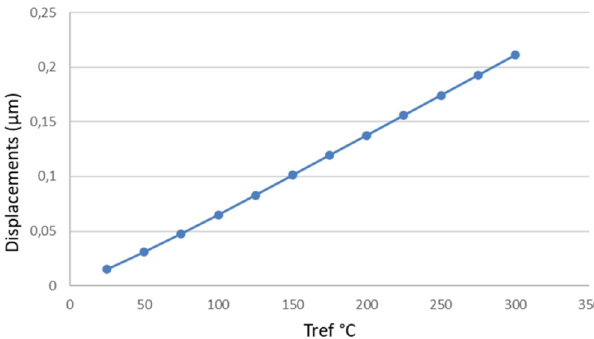
Fig. 6. Evolution of maximum displacements as a function of the reference temperature in the HEMT structure.